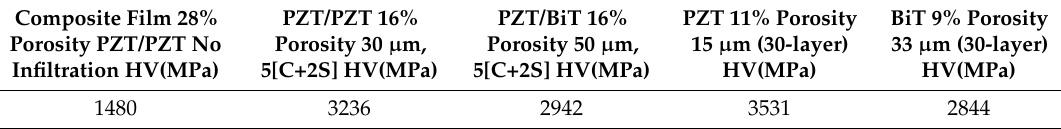
Table 2. Micro-hardness values for piezoelectric composite films under 200 g load for 30 s.